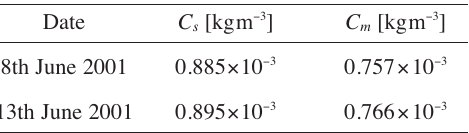
Table I. The column labeled with C s represents the value at 2.5 m level at location 1 of (Werner et al ., 2003) of the simulated gas concentrations. The meas- ured values at 2.5 m level in the location 1 of Wern- er et al . (2003) are reported in the column labelled with C m . A background CO 2 concentration of 0.70 × × 10 − 3 kgm − 3 was considered.